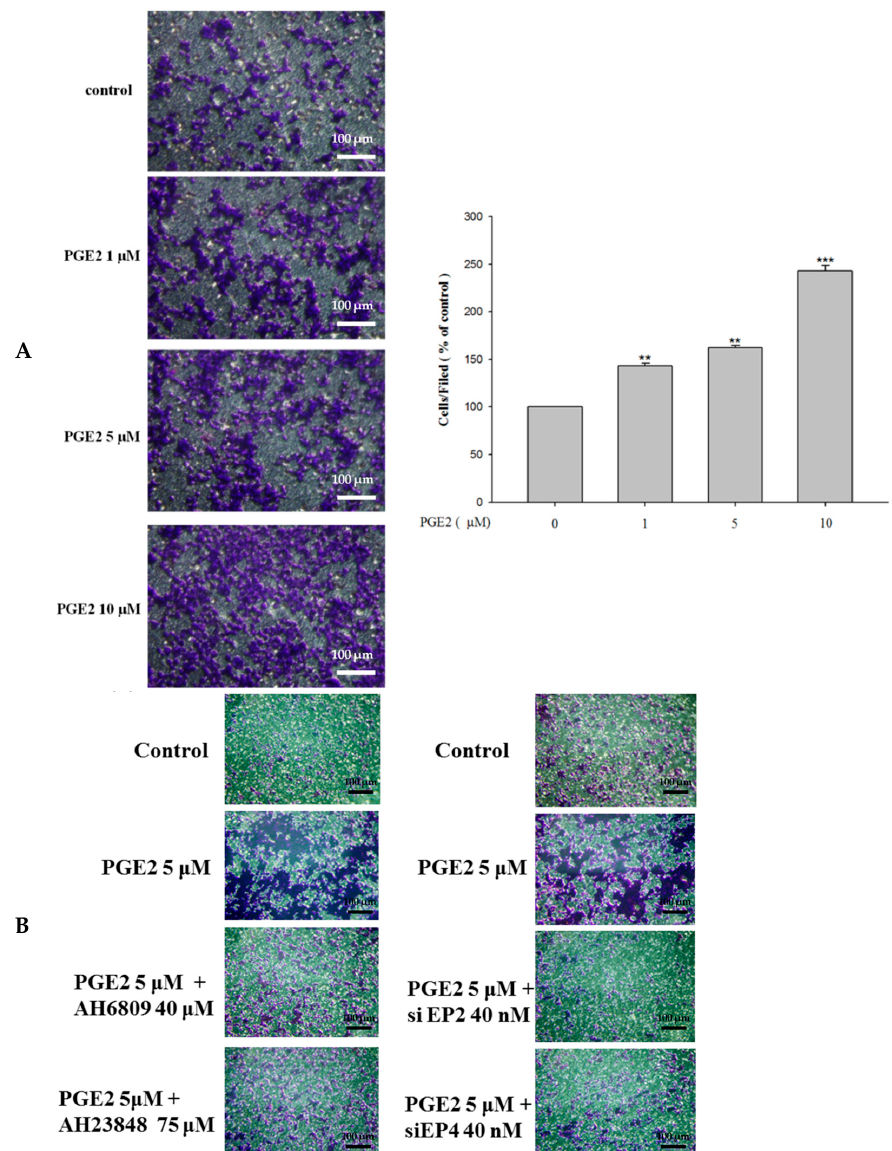
Figure 5. PGE2 can efficiently promote the migration ability of LoVo cells. ( A ) LoVo cells were pretreated with increasing concentrations of PGE2 (0, 1, 5 and 10 μ M) for 6 h. Cells were harvested and migration ability was subsequently evaluated by a migration assay. ( B ) The use of antagonists or siRNA reduces the migration ability of LoVo cells. The responses to different treatments were observed and analyzed with a fluorescence microscope. *** p < 0.001 versus control. **, p < 0.01 versus control (mean ± SD, n = 3).